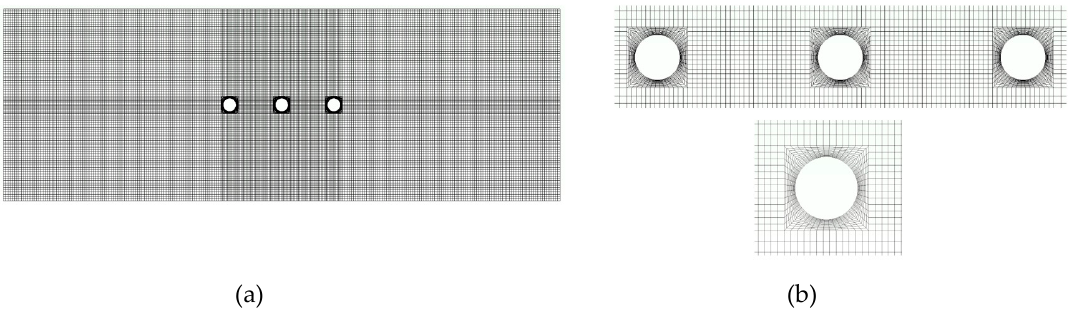
Figure 3. ( a ) Discretized model for the three cylinders with d = 4.0 D , ( b ) a closer view of the grids for single cylinder and triple cylinders.